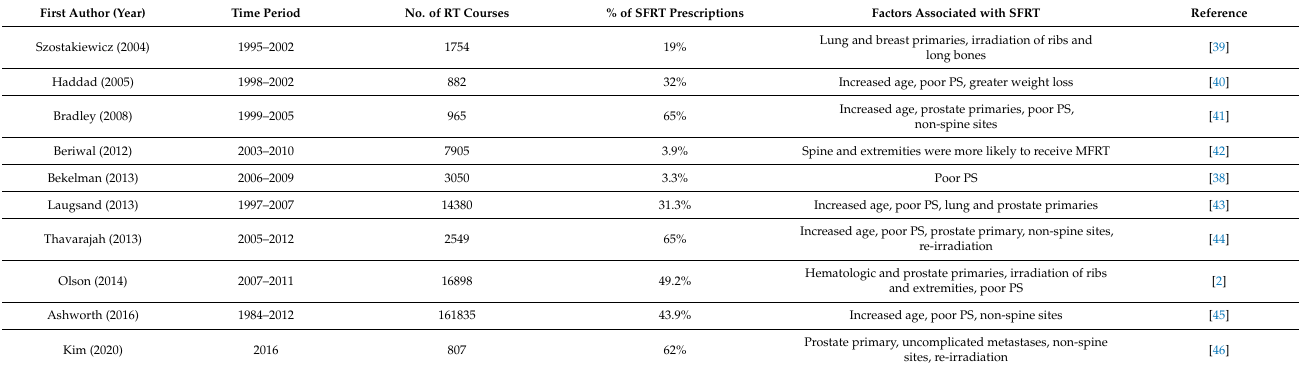
Table 7. Patterns of practice regarding irradiation regimens in bone